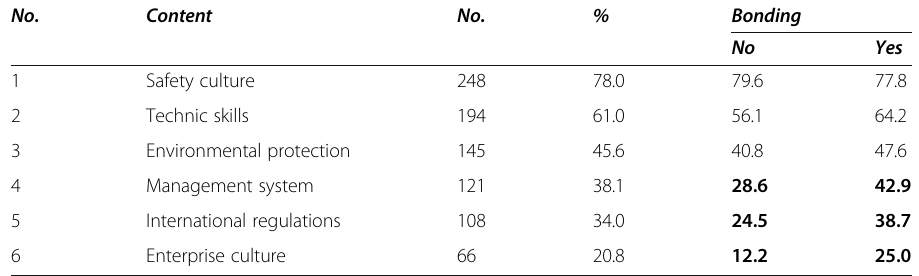
Table 8 Use/helpfulness of training courses (%) by type of bonding (%) No.